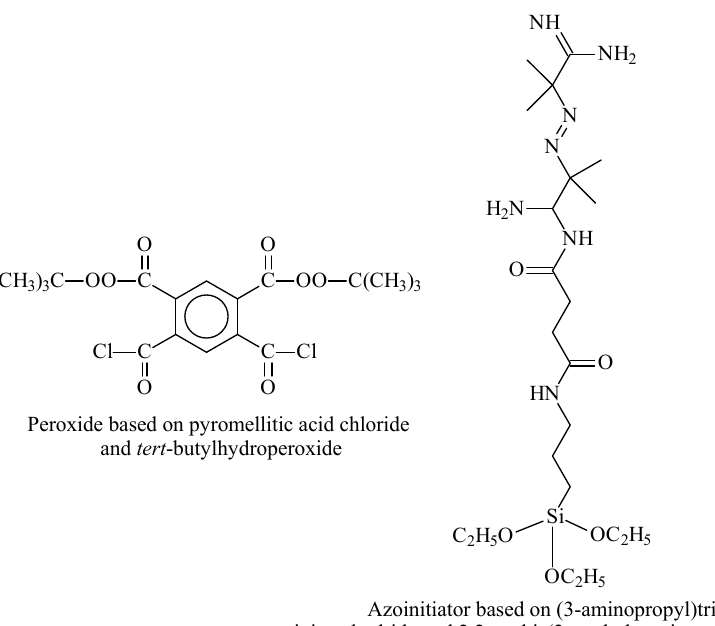
Figure 7. The most common multifunctional initiators for SI-PP or SI-AP.